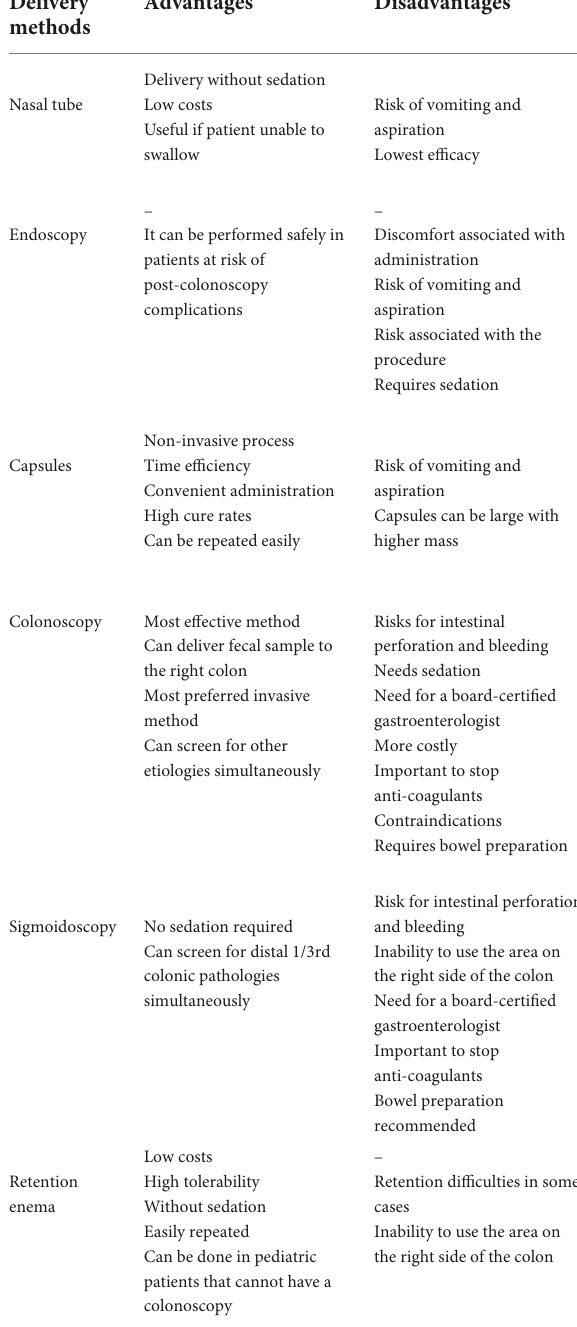
TABLE 3 Fecal microbiota transplant (FMT) delivery methods with advantages and